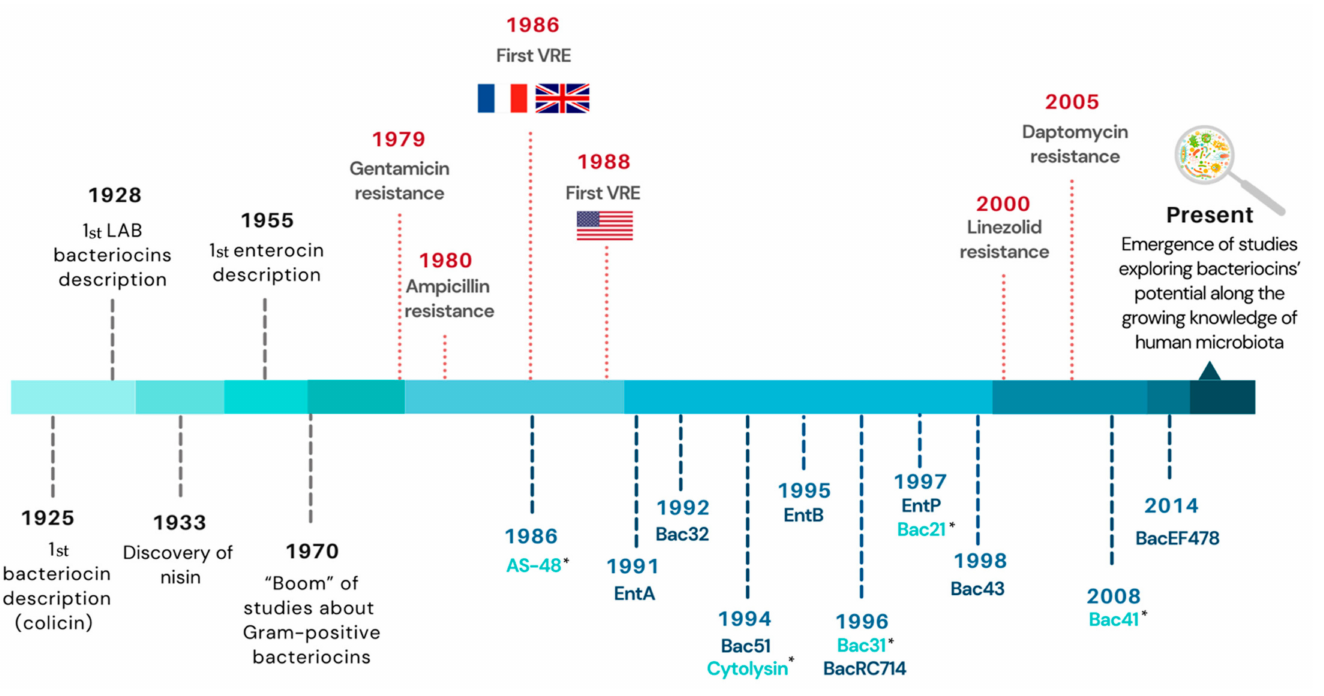
Figure 1. Timeline of important events in the history of bacteriocins. Enterocins specifically described in clinical enterococci isolates so far are included as blue lines: dark blue indicates enterocins produced by E. faecium and light blue by E. faecalis ; the years indicated correspond to the first mention of a given enterocin, either the year of isolation or, whenever unknown, the year of bacteriocin description/publication (marked with * in the latter case). The year corresponding to the appearance of the most clinically relevant antibiotic resistance in enterococci appear as red lines. Abbreviations: LAB, lactic acid bacteria; VRE, vancomycin-resistant enterococci; Bac, bacteriocin; Ent,